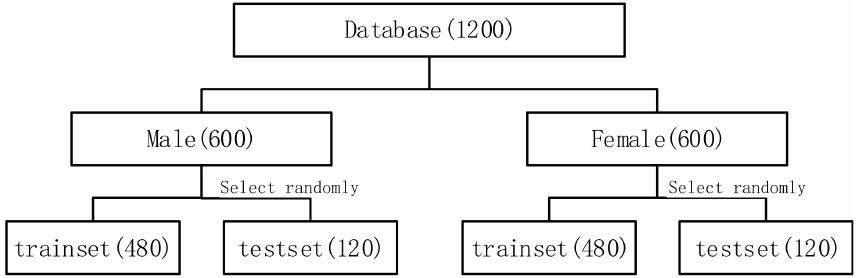
Figure 5. Dataset